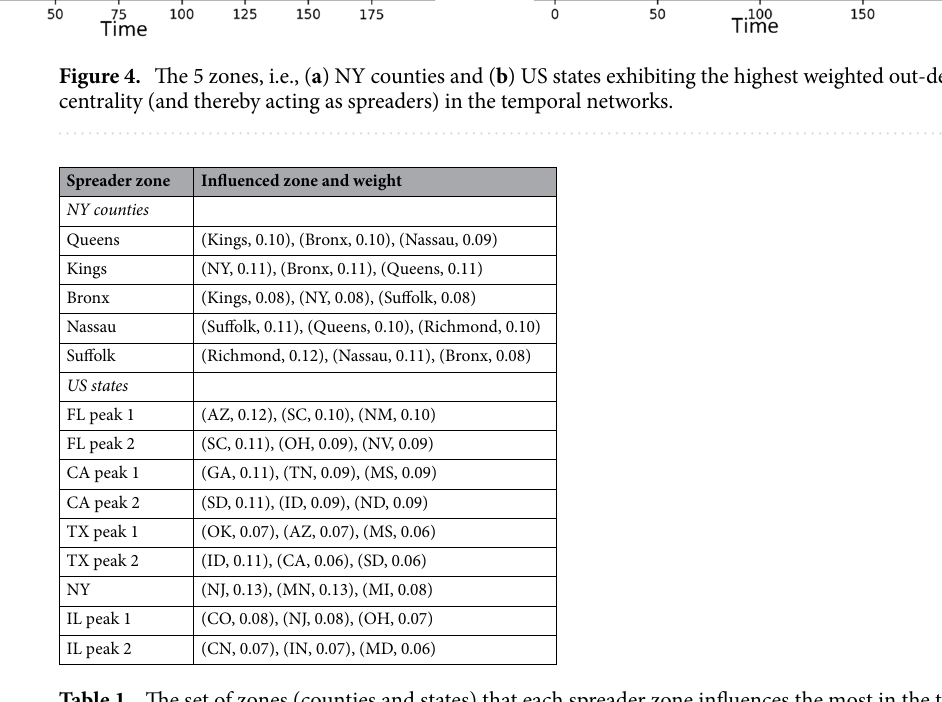
Table 1. The set of zones (counties and states) that each spreader zone influences the most in the temporal network where its out-degree centrality peaks (single or multiple times).